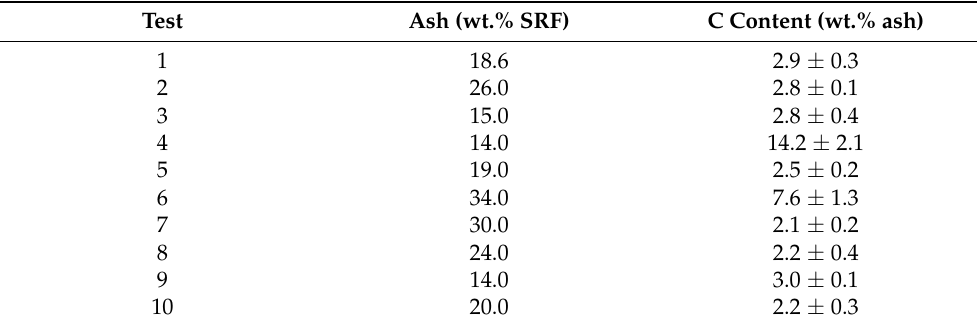
Table 4. Amount of ash and C content in ash obtained in the SRF combustion tests.